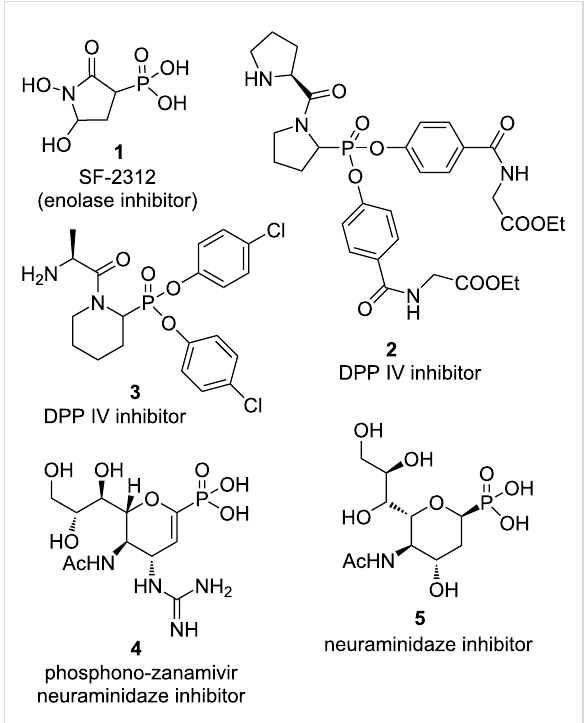
Figure 1: Pharmacologically active nonracemic phosphonates with heterocyclic moieties.